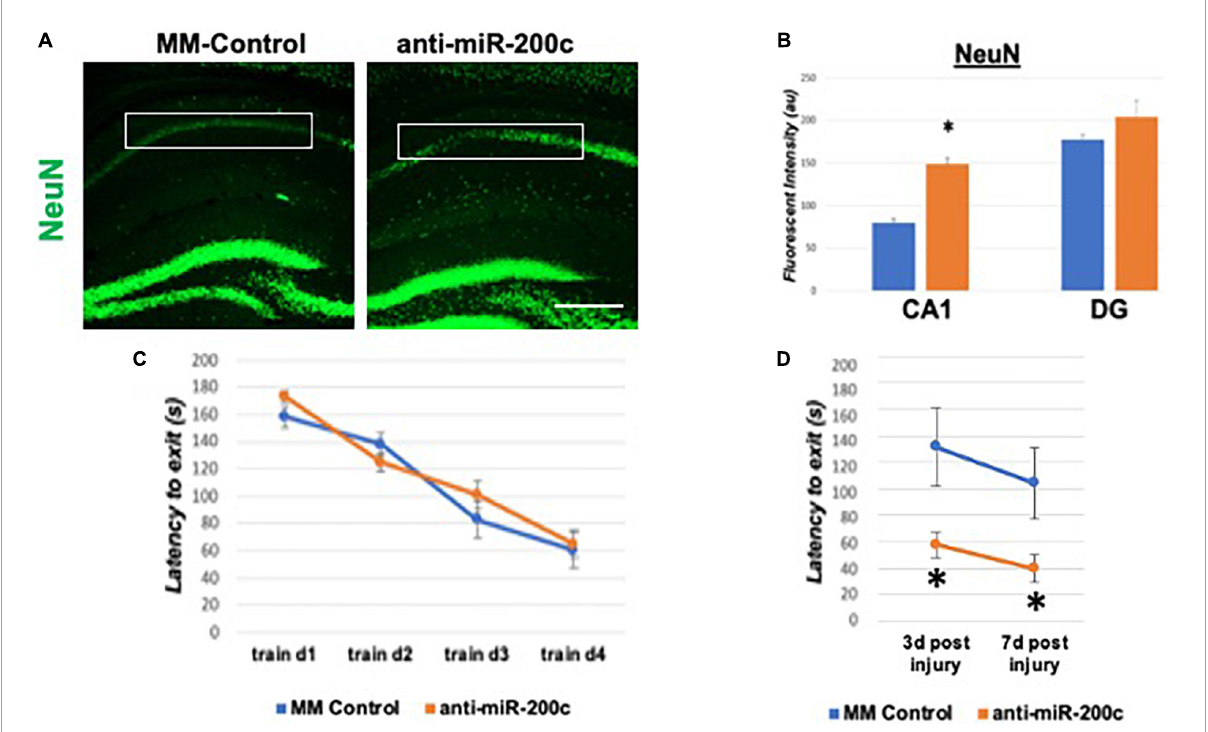
FIGURE2 Effect of 2 h post-injury intravenous anti-miR-200c or MM-control treatment on sirtuin-1 (SIRT1) expression 7 days after global cerebral ischemia in mice. (A) Representative images of fluorescent IHC labeling for neurons (NeuN, green) in mouse hippocampus 7 days after global cerebral ischemia with and without post-injury anti-miR-200c treatment. (B) Quantification of post-injury CA1 NeuN fluorescence with and without IV anti-miR-200c post-treatment. (C) Escape latency during pre-injury Barnes maze training. (D) Escape latency at post-injury days 3 and 7 in mice with and without IV anti-miR-200c post-treatment. ( N = 5–8 animals per treatment group, mean ± SEM, * p < 0.05). Scale bar, 1